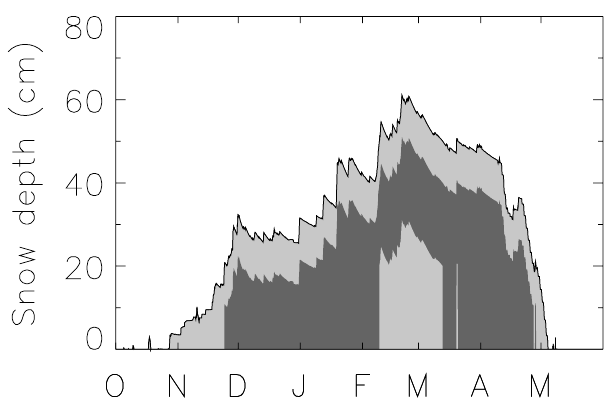
Fig. 3. Simulation of seasonal snow depth with JULES for multi- level snow scheme, showing the division into a varying number of layer depths. The full shaded area shows the total snow depth, whilst the different shadings represent the depths of the various snow layers. Minimum layer thicknesses can be selected by the user, but in this illustration a second layer is added when the snow depth exceeds 20cm and a third at